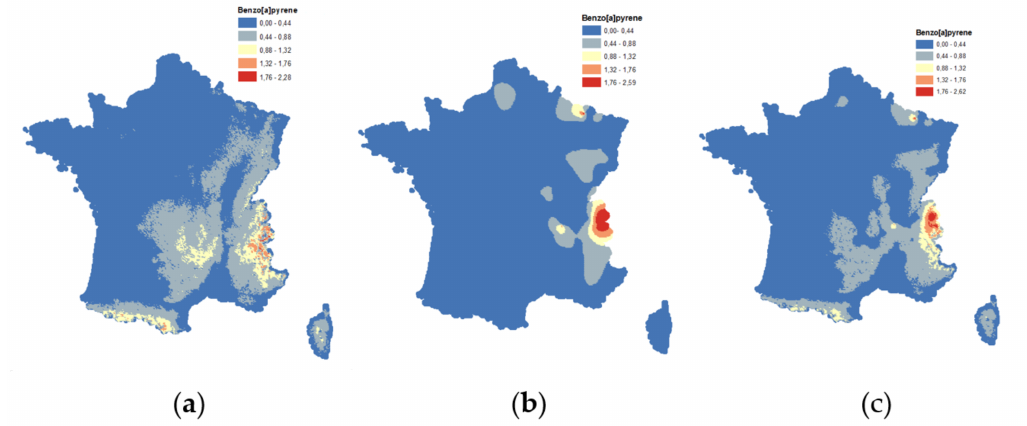
Figure 9. Estimated concentrations of the B[a]P measurements (ng/m 3 ) in ambient air, for ( a ) 2010, ( b ) 2011, and ( c ) combined estimated concentration of the B[a]P measurements in ambient air, for both